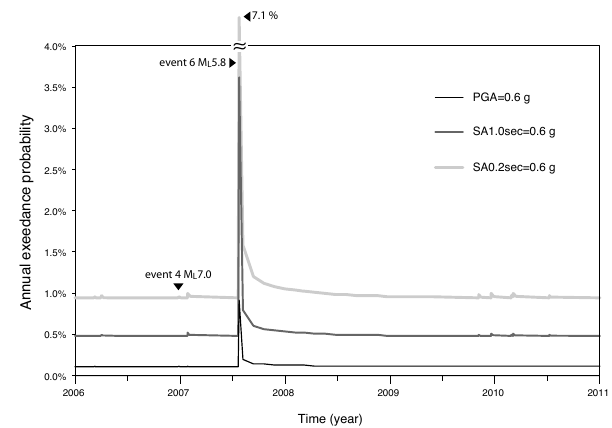
Fig. 11. Assumed ground shaking of 0.6g for PGA (black line), SA1.0s (gray line), and 0.2s (light-gray line), the temporal evolu- tion of the annual exceedance probability in Hualien City from 2006 until